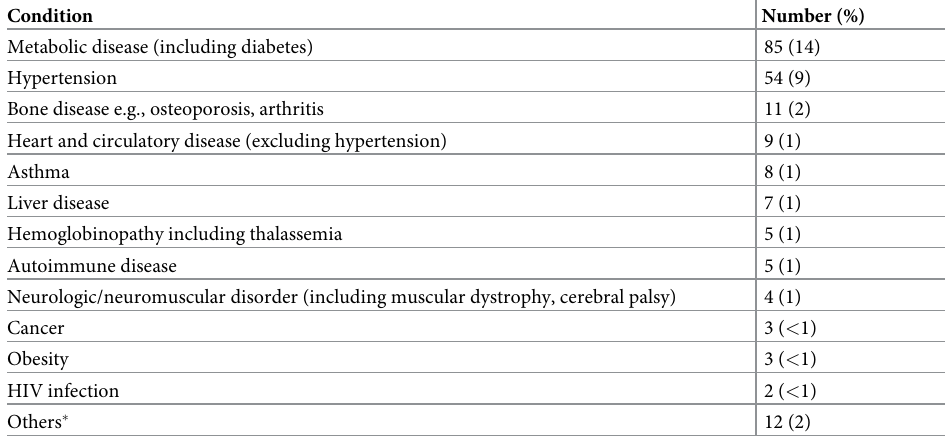
Table 2. Pre-existing medical conditions among the study participants who reported at least one condition at enrollment.